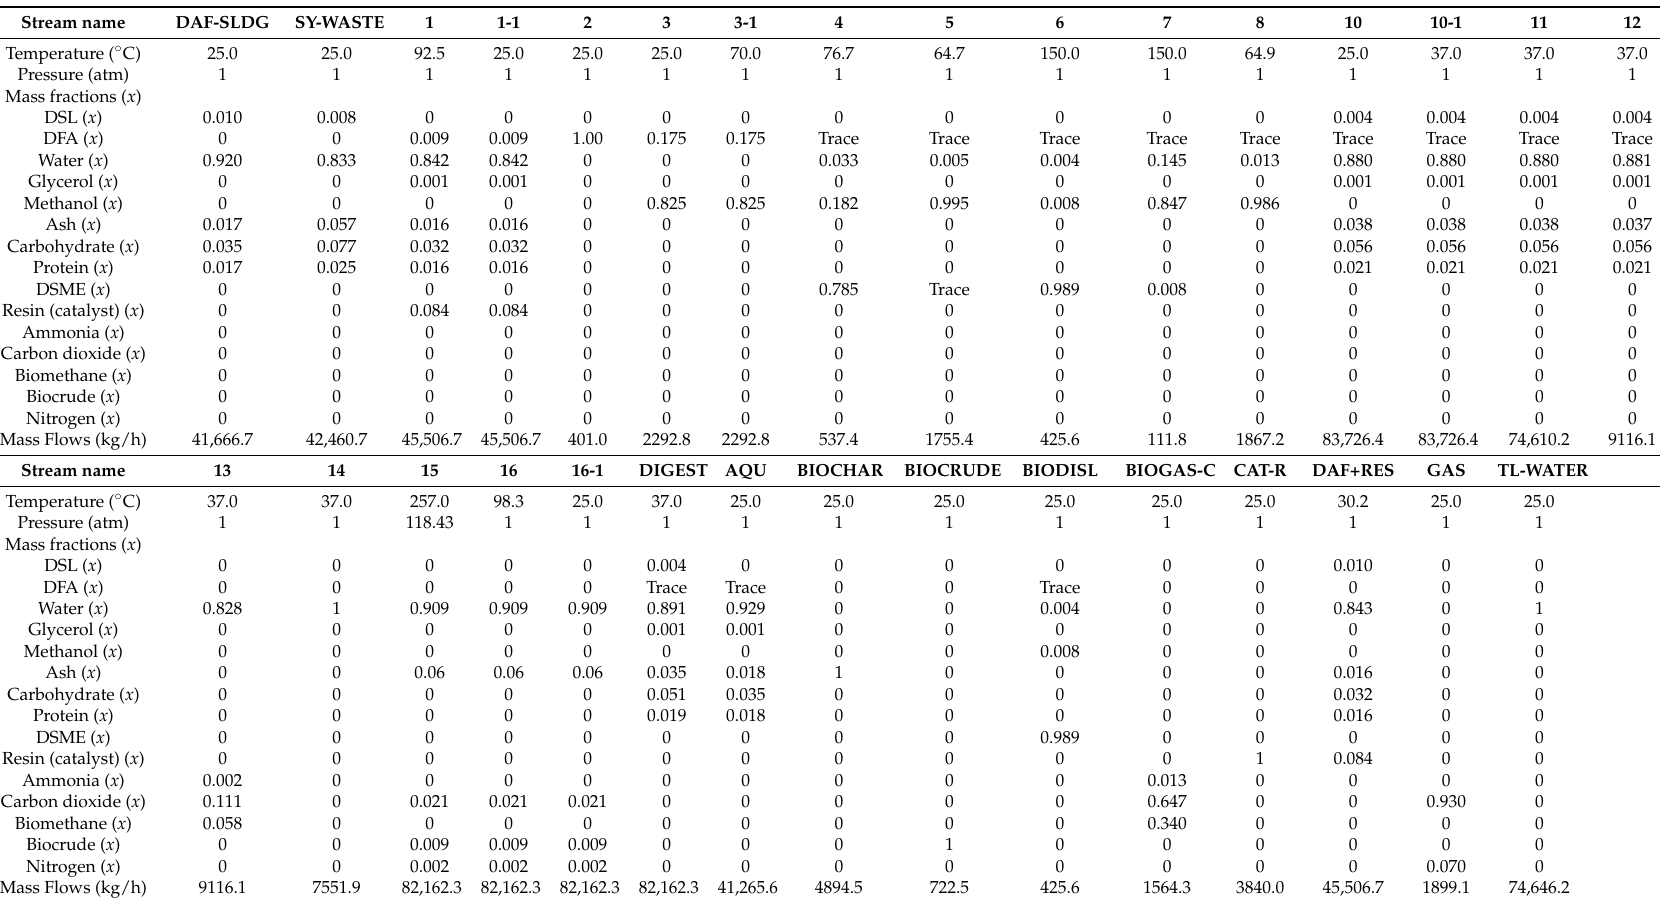
Table 1. The simulation results of the major streams in the process flow sheet for the proposed biorefinery